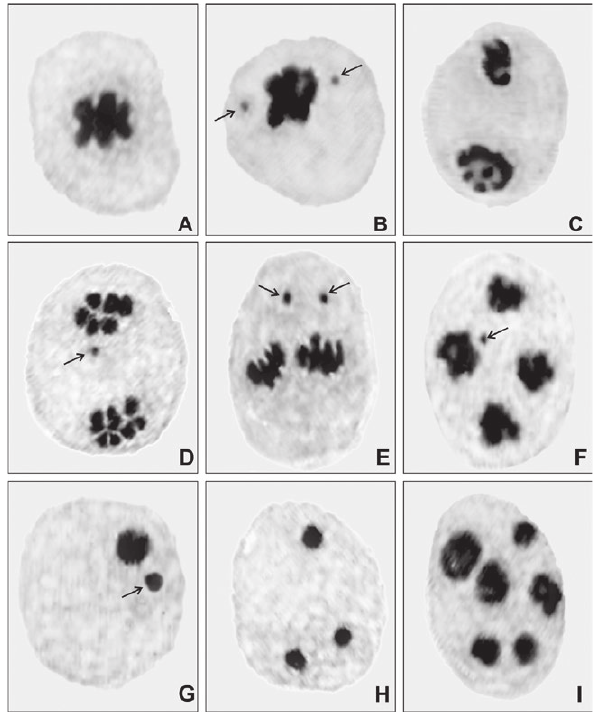
Figure 6. Different types of abnormalities in treated plants of Arte-